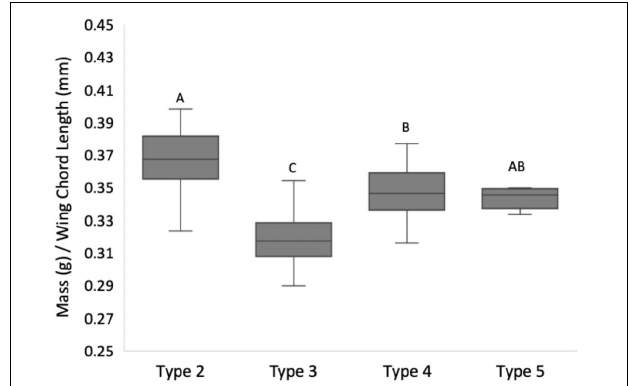
FIGURE 4 | Wing loading in red crossbill ecotypes 2, 3, 4, and 5. The mass to wing chord length quotient in lean red crossbills was lowest in type 3 and highest in type 2. Box plots show inter-quartile range and median lines, whiskers give 95% CI. Box plots with different letters are significantly different based on Tukey comparisons of means ( P < 0.0001). Sample sizes are 34 type 2, 96 type 3, 51 type 4, and 9 type 5